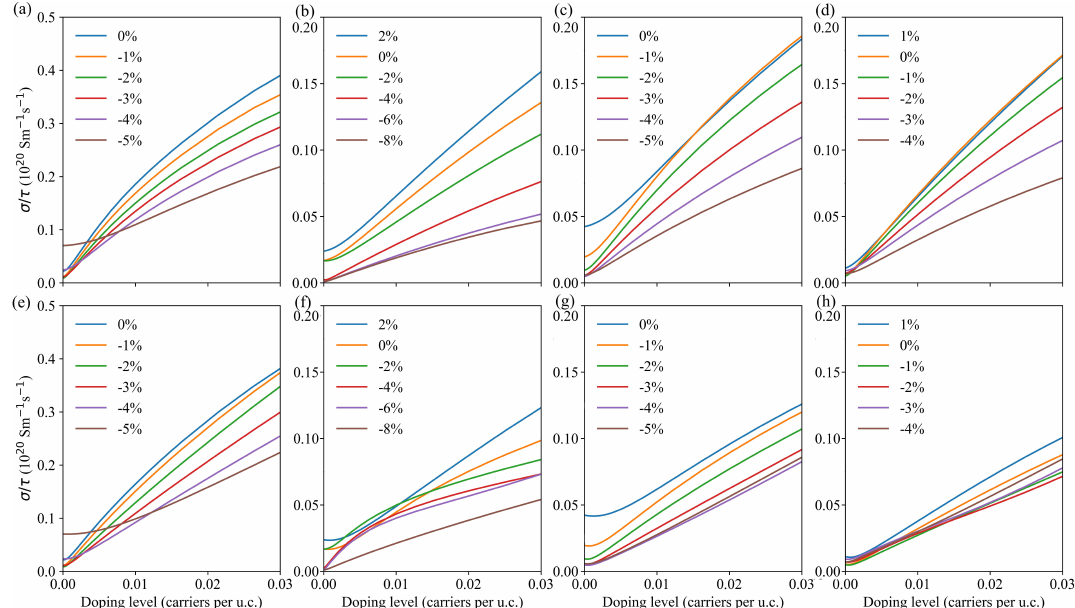
Figure 7. τ -scaled electronic conductivity of Bi 2 Te 3 ( a , e ), PbBi 2 Te 4 ( b , f ), PbBi 4 Te 7 ( c , g ) and Pb 2 Bi 2 Te 5 ( d , h ) vs. carrier concentrations for various compressive and tensile strains. Top figures correspond to p -type doping and bottom figures to n -type